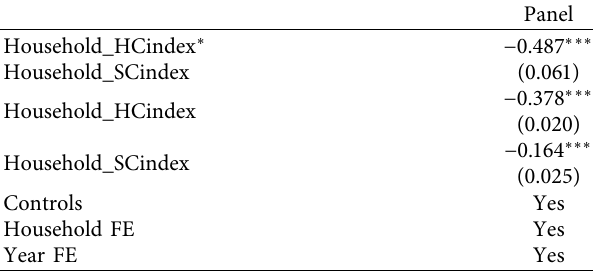
Table 6: Moderating effect of social capital.